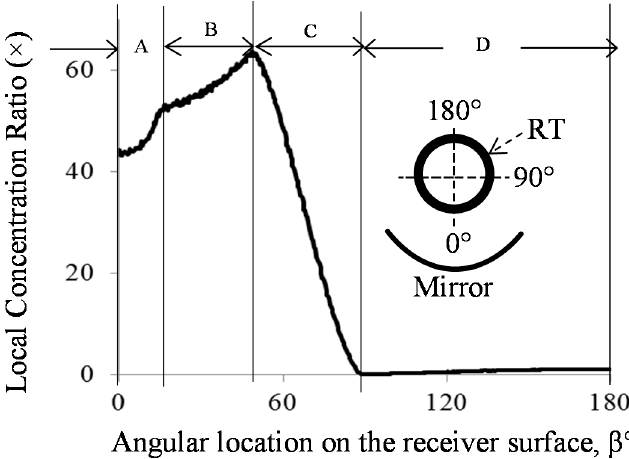
Figure 5. LCR profile around the receiver tube (RT) of the LS2 collector at ideal condition. The profile is bi-symmetric about 0°–180° axis of the receiver, and theoretically uniform along the length of the receiver. The LCR profile contains four distinct zones, such as, A : Receiver Shadowing (RS) zone; B : Concentration Increasing (CI) zone; C : Concentration Falling (CF) zone, and D : Direct Sun (DS) zone.